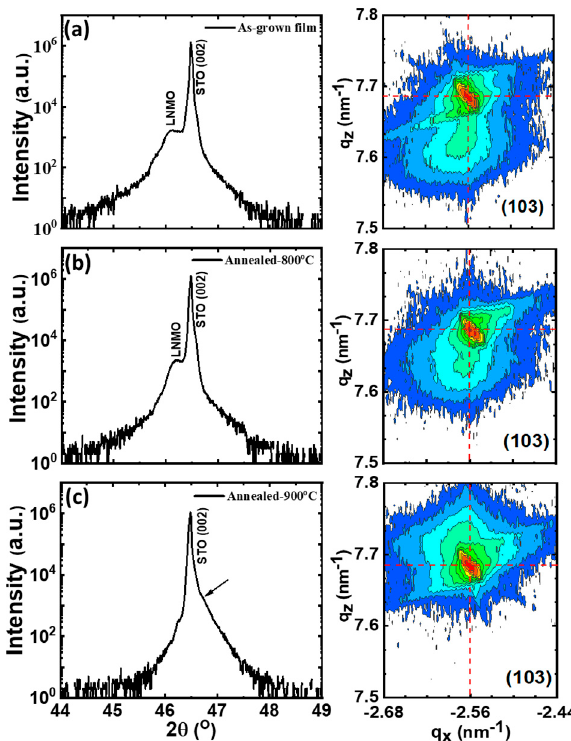
Figure 3. High-resolution θ /2 θ XRD scans of the (002) reflections ( left ) and RSM around (103) reflection ( right ) of the same LNMO thin film (thickness, t = 48 nm) after different annealing processes: ( a ) as-grown film, ( b ) annealing at 800 °C and ( c ) annealing at 900 °C. The arrow indicates position of LNMO peak and the red dotted line indicates the position of the STO peak.